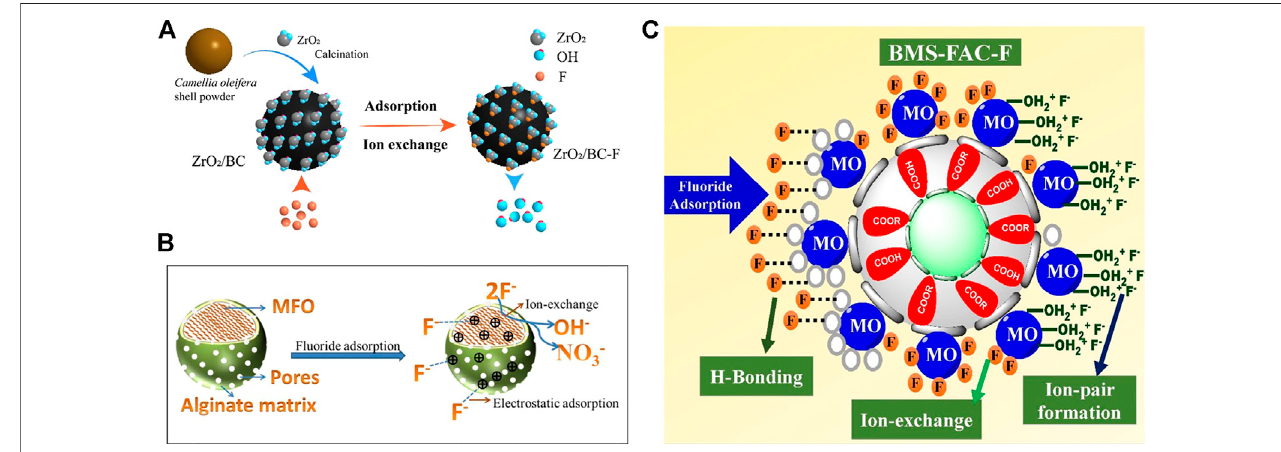
FIGURE 9 | Respective adsorption mechanisms of composite adsorbents from different metal-modi fi ed materials. (A) : ion exchange (Mei et al., 2020), (B) : electrostatic attraction (Wu T. et al., 2017), (C) : ion pair (Raghav et al., 2019).